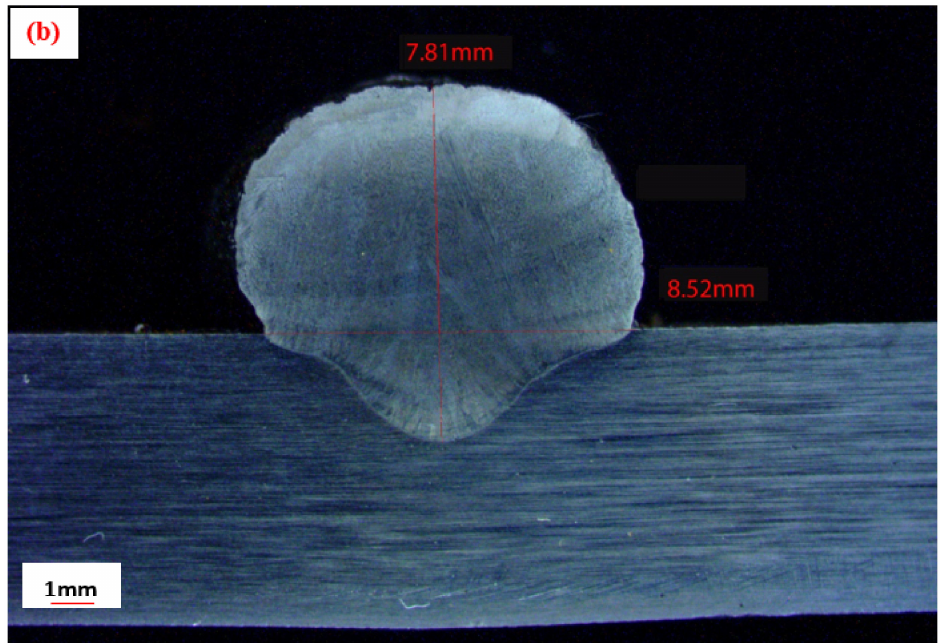
Figure 8. Optical micrograph for ( a ) minimization of BW, ( b ) maximization of BH.